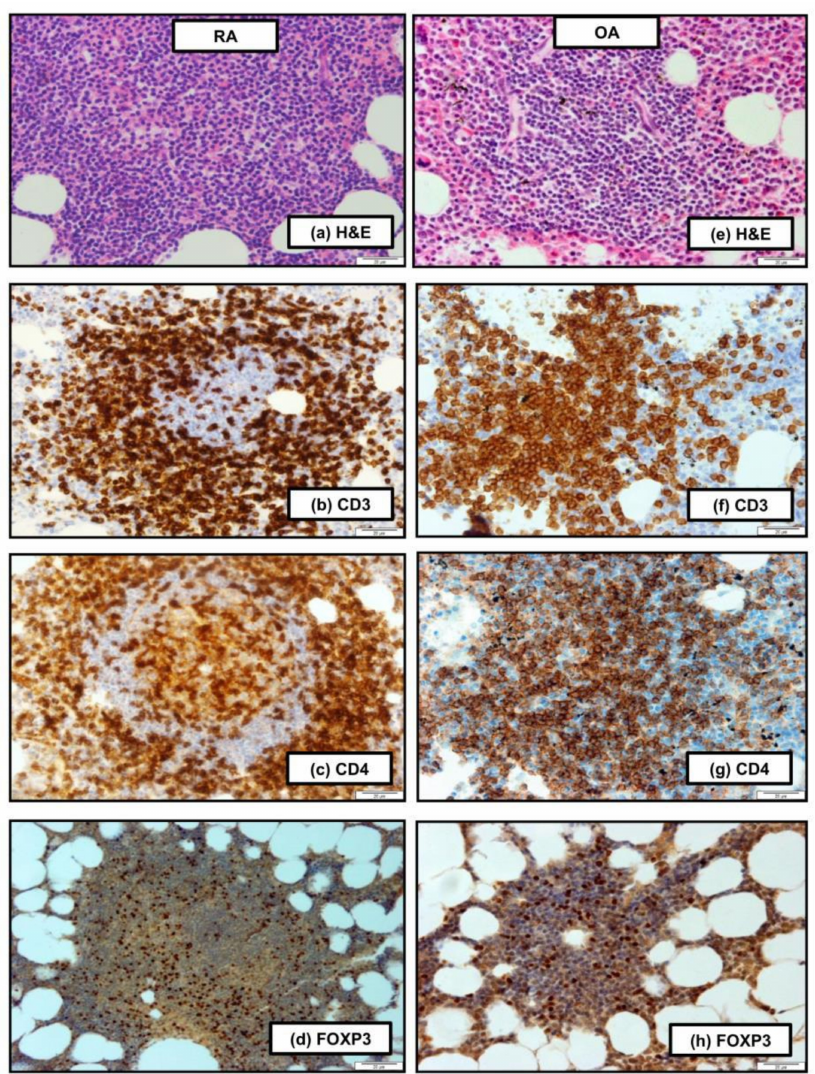
Figure 1. Histopathological features of the bone marrow (BM) of patients with rheumatoid arthritis (RA) ( a – d ) and osteoarthritis (OA) ( e – h ). ( a ) Nodular lymphocytic infiltration with germinal center formation (hematoxylin and eosin [H&E] stain, 100 × ). ( b ) CD3 + T cells in the marginal and mantle zone. ( c ) CD4 + T cells in the lymphoid follicle. ( d ) Nuclear expression of FOXP3 in cells localized in the lymphoid follicle. ( b – d : EnVision stain, 100 × ). ( e ) H&E staining shows visible nodular lymphocytic infiltration, 100 × . ( f , g ) Most of the lymphocytes in the lymphoid follicle revealed CD3 and CD4 expression. ( h ) FOXP3 in nuclear localization in cells of the lymphoid follicle ( f – h : EnVision stain, 100 − ). Scale bar, 20 µ m. Histology staining was done on five patients in each group while one representative is shown. 3.2. Proportions of CD4 + FOXP3 + T Cells Are Lower in RA than in OA BM + + + The proportion of CD4 FOXP3 cells among the CD4 population was significantly lower in